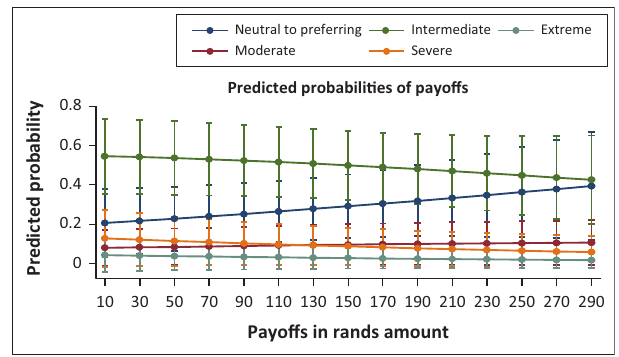
FIGURE 2: Gains and losses games – Distribution of risk